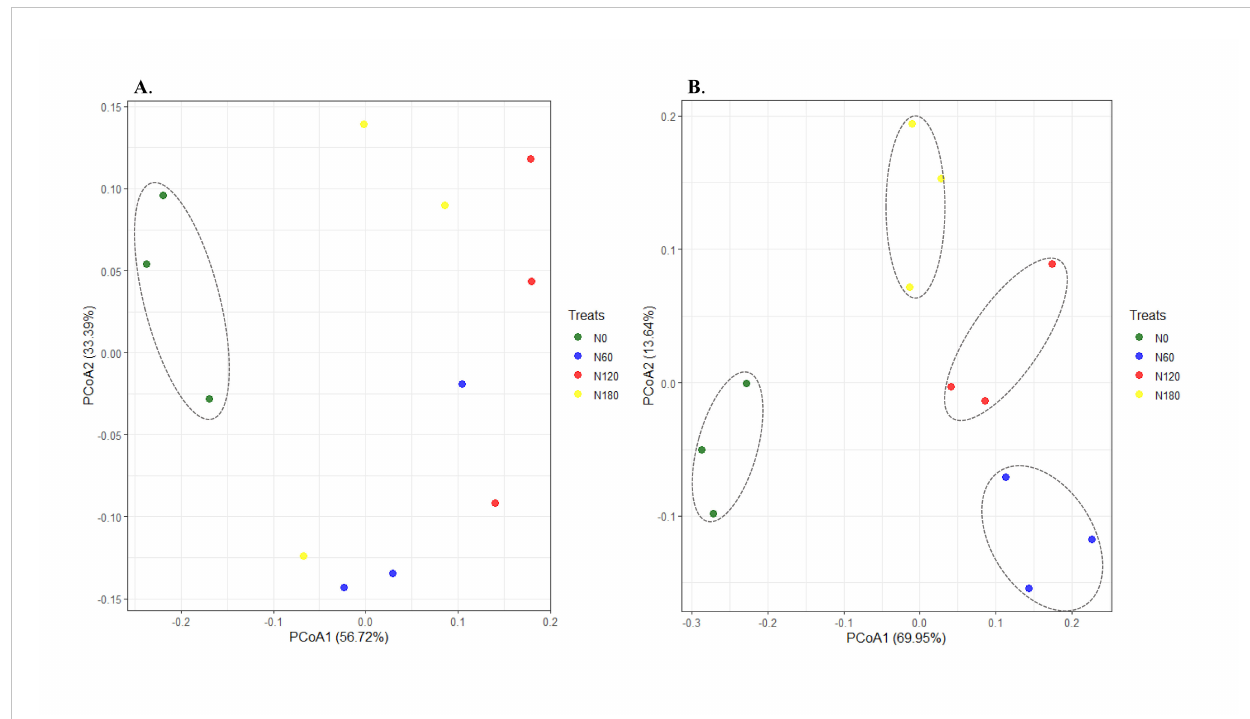
FIGURE 2 Principal coordinate analysis (PCoA) of soil bacterial (A) P =0.095 and fungal (B) P =0.075 communities across the four treatments based on Bray- curtis